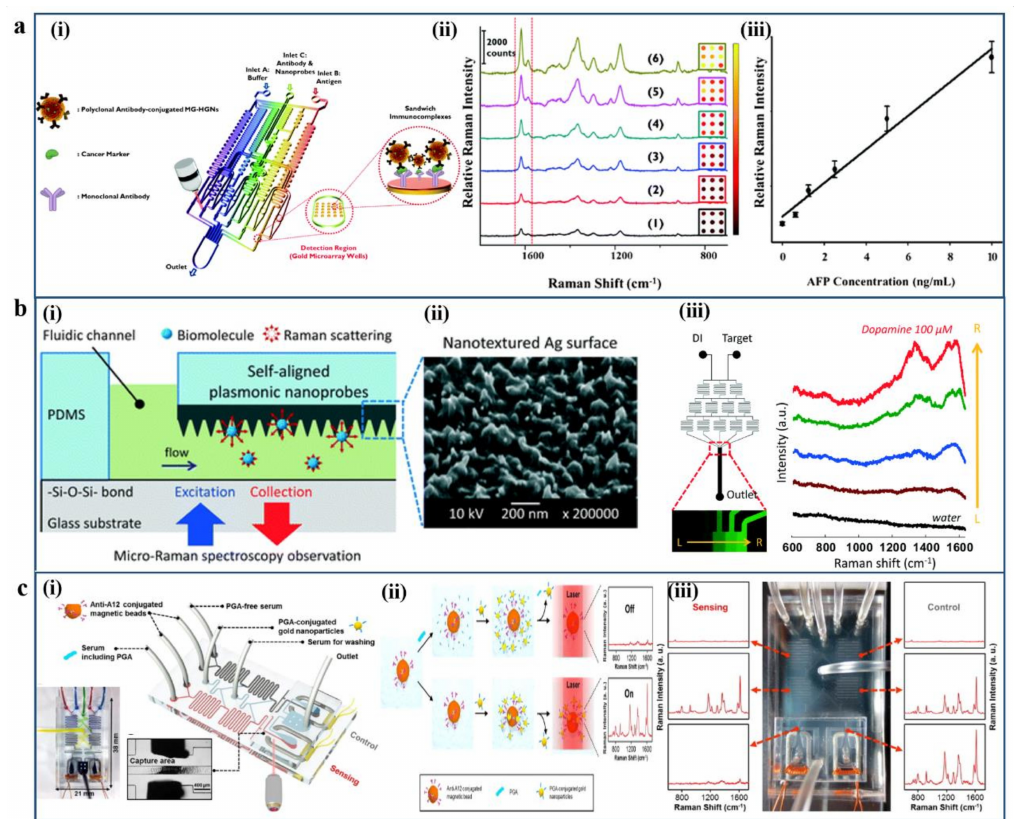
Figure 9. Examples of SERS-based microfluidic biosensing platforms. ( a ) SERS-based immunoassay with gold-patterned microarray wells-embedded gradient microfluidic chip: ( i ) Schematic illustration of gold-patterned microarray wells- embedded gradient microfluidic chip ( ii , iii ) SERS-based quantitative immunoassay for alpha-fetoprotein (AFP) model protein marker AFP antigen. Reproduced with permission from [129]. Copyright 2012 Royal Society of Chemistry. ( b ) Optofluidic SERS chip with self-aligned plasmonic nanoprobes along microfluidic channels. ( i ) Schematic illustration of the optofluidic SERS chip. ( ii ) SEM image of plasmonic nanoprobes self-aligned along microfluidic channels. ( iii ) Optofluidic SERS detection of dopamine molecules. Reproduced with permission from [130]. Copyright 2013 Royal Society of Chemistry. ( c ) SERS-based solenoid microfluidic sensor for anthrax biomarker detection. ( i ) Schematic illustration of SERS-based solenoid-embedded dual-channel microfluidic sensor for competitive immunoassay. ( ii ) Schematic illustration of the principle of the PGA marker competitive immunoassay in serum by SERS spectra. ( iii ) Photograph of the solenoid- embedded microfluidic chip and SERS spectra at six different channel positions. Reproduced with permission from [131]. Copyright 2015